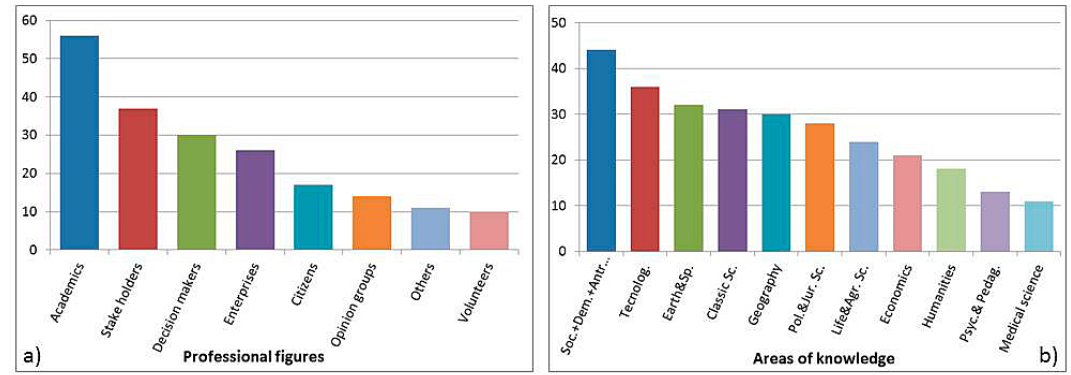
fig. 3. no. of projects involving different categories of people (a) and different areas of knowledge